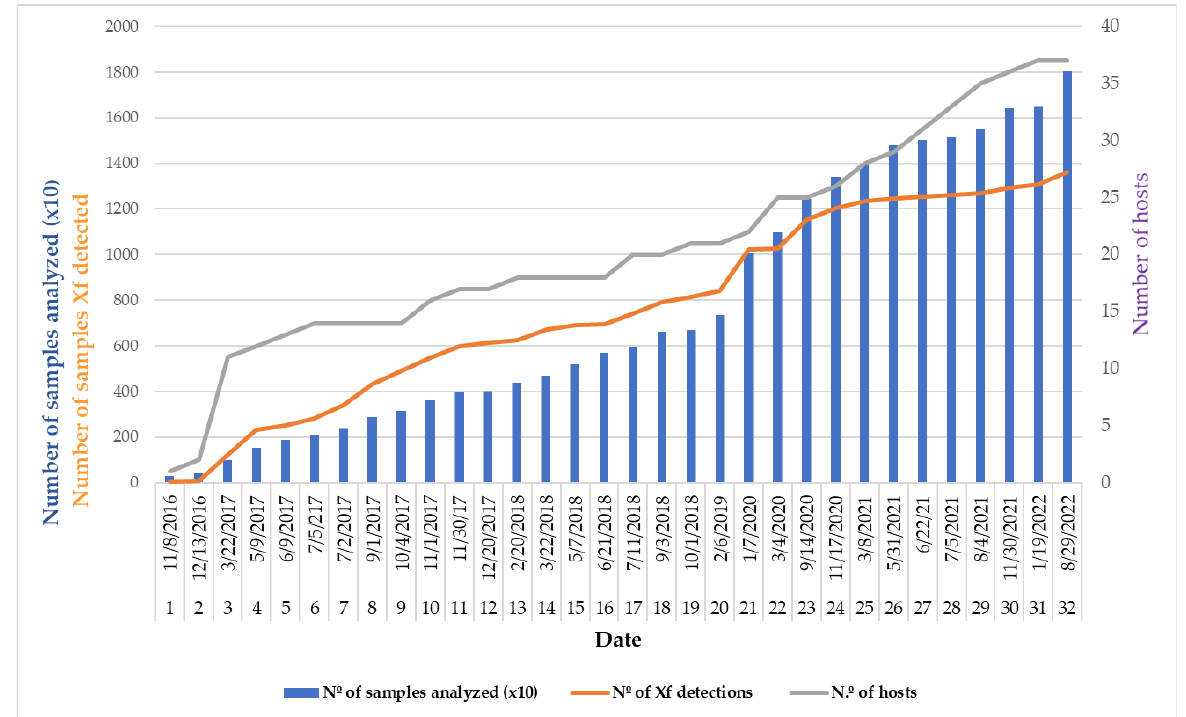
Figure 2. Progression of the number of total samples, Xf-qPCR-positive samples, and hosts over time in the Balearic Islands . Table 1. Host plants for Xylella fastidiosa recorded in the Balearic Islands in 2022.